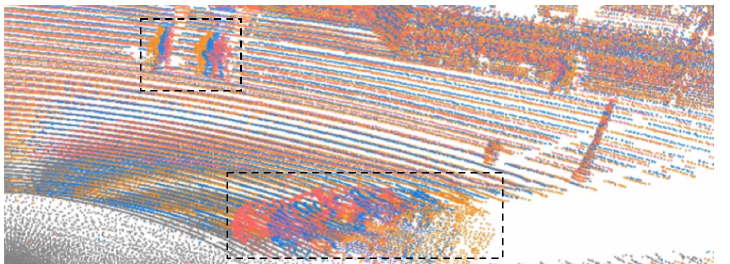
Figure 1. Multiple frames are concatenated into one frame by registration. The black dashed box marks the area where motion blur